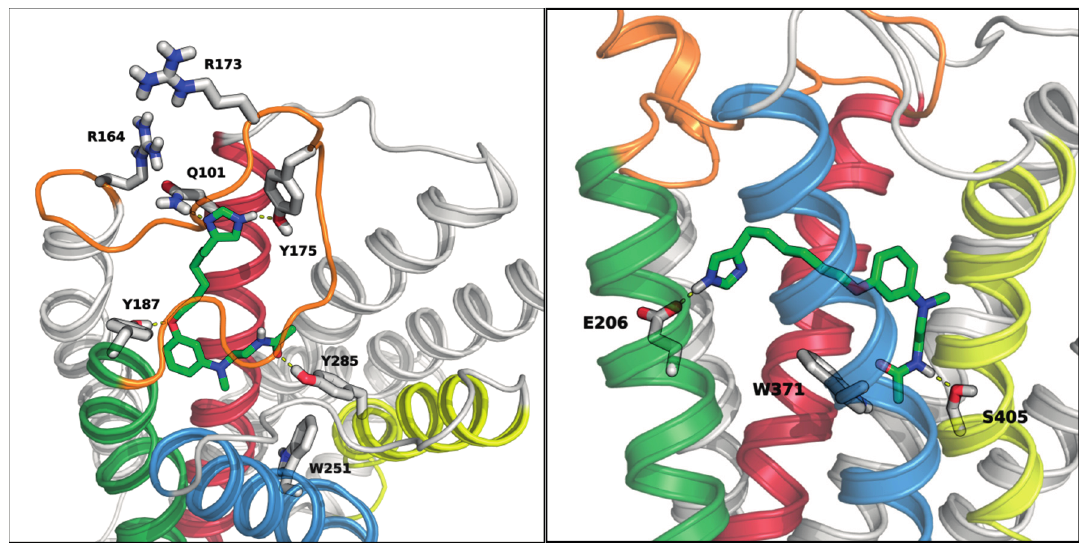
Figure 4. ( Left ) hypothetical binding conformation of compound 14d (green carbons) within an MT 1 receptor model (light gray carbons) [31]. Transmembrane helices 3, 5, 6 and 7 are colored red, green, blue and yellow, respectively, while extracellular loop 2 is depicted in orange; ( Right ) hypothetical binding conformation of 14d within an H 3 receptor model (light gray carbons) [45]. Transmembrane helices 3, 5, 6 and 7 are colored red, green, blue and yellow, respectively, while extracellular loop 2 is depicted in